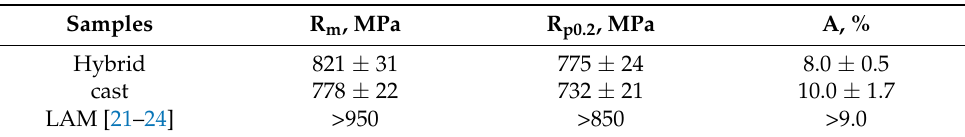
Table 1. Room temperature tensile properties of hybrid manufacturing TC4 sample, pure casting TC4 sample and LAM sample, data from [21 – 24].